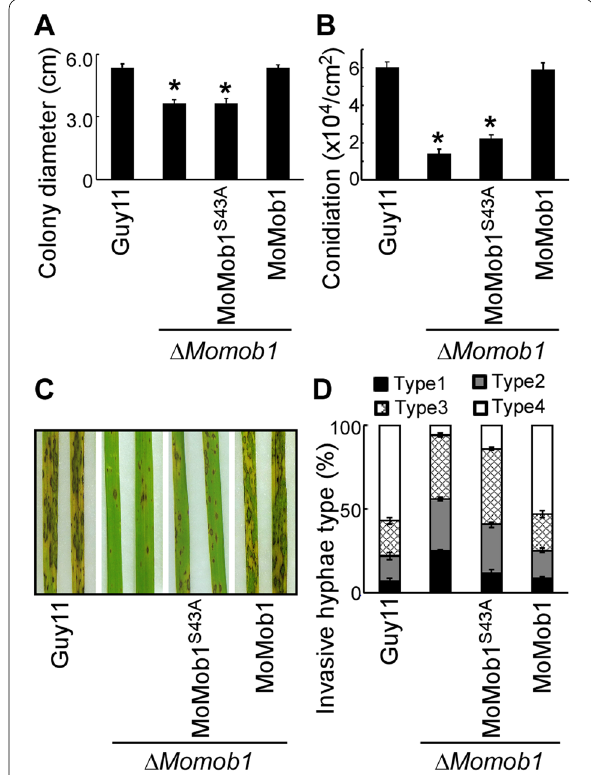
Fig. 5 MoSep1-dependent MoMob1 phosphorylation is vital for vegetative growth, conidiation, and pathogenicity of M. oryzae . A Statistical analysis of colony diameters from wild-type Guy11, mutants Δ Momob1 and Δ Momob1/MoMOB1 S43A , and complemented strain Δ Momob1/MoMOB1 on CM medium. Error bars represent standard deviations from three independent experiments. Asterisks indicate statistical significance according to a Student’s test ( p < 0.01). B Statistical analysis of conidia production on SDC medium cultured at 28 °C for 7 days in the dark followed by 3 days of continuous illumination under f﻿luorescent light. Error bars represent the standard deviations from three independent experiments. Asterisks indicate statistical significance according to a Student’s test ( p < 0.01). C Pathogenicity analysis using rice spraying assays and images were photographed at 7 dpi. D Statistical analysis